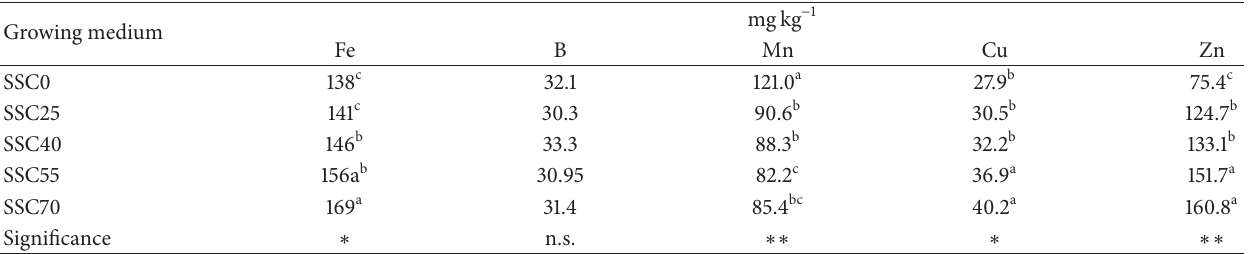
Table 10: Concentrations of micronutrients in tissues of Bougainvillea plants as influenced by growing media (150DAT, on dry matter basis). Growing